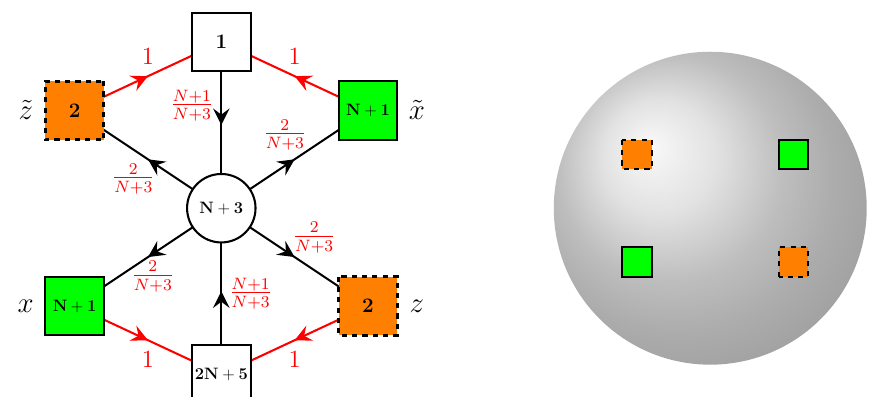
Figure 12: Quiver of the A four-punctured sphere theory obtained by S gluing two N three punctured spheres. Note that there are superpotentials corresponding to the triangles as well as certain baryonic superpotentials preserving the puncture symme-